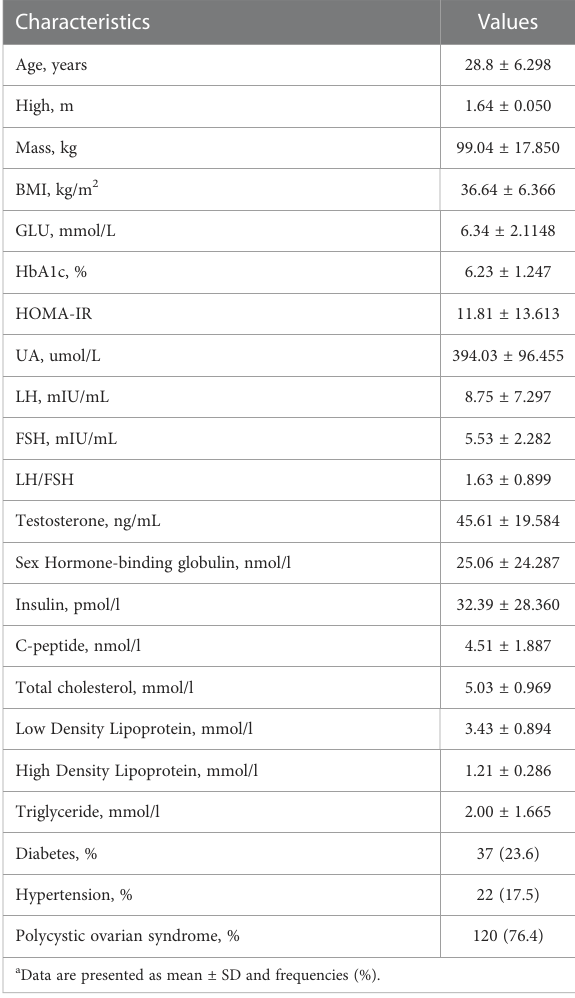
TABLE 1 Preoperative Characteristics of Patients Included a